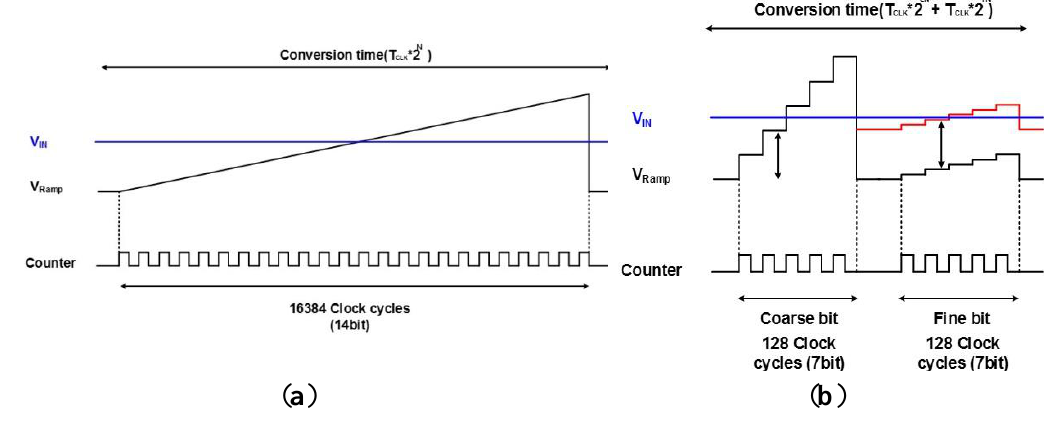
Figure 1. Principle of Single-Slope ADC and Two-Step Single-Slope ADC: ( a ) 14-bit single-slope ADC (SS ADC); ( b ) 14-bit two-step single-slope ADC (TS SS ADC).